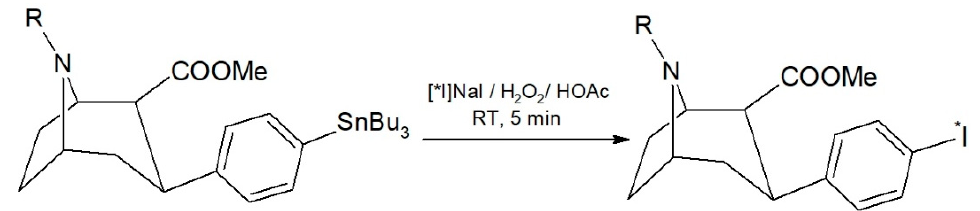
Figure 1. Scheme of the radioiodination of β -CIT (R = CH 3 ) using acidified H 2 O 2 as an oxidizing agent. The reaction time was 5 min at room temperature (RT, 18–25 °C).